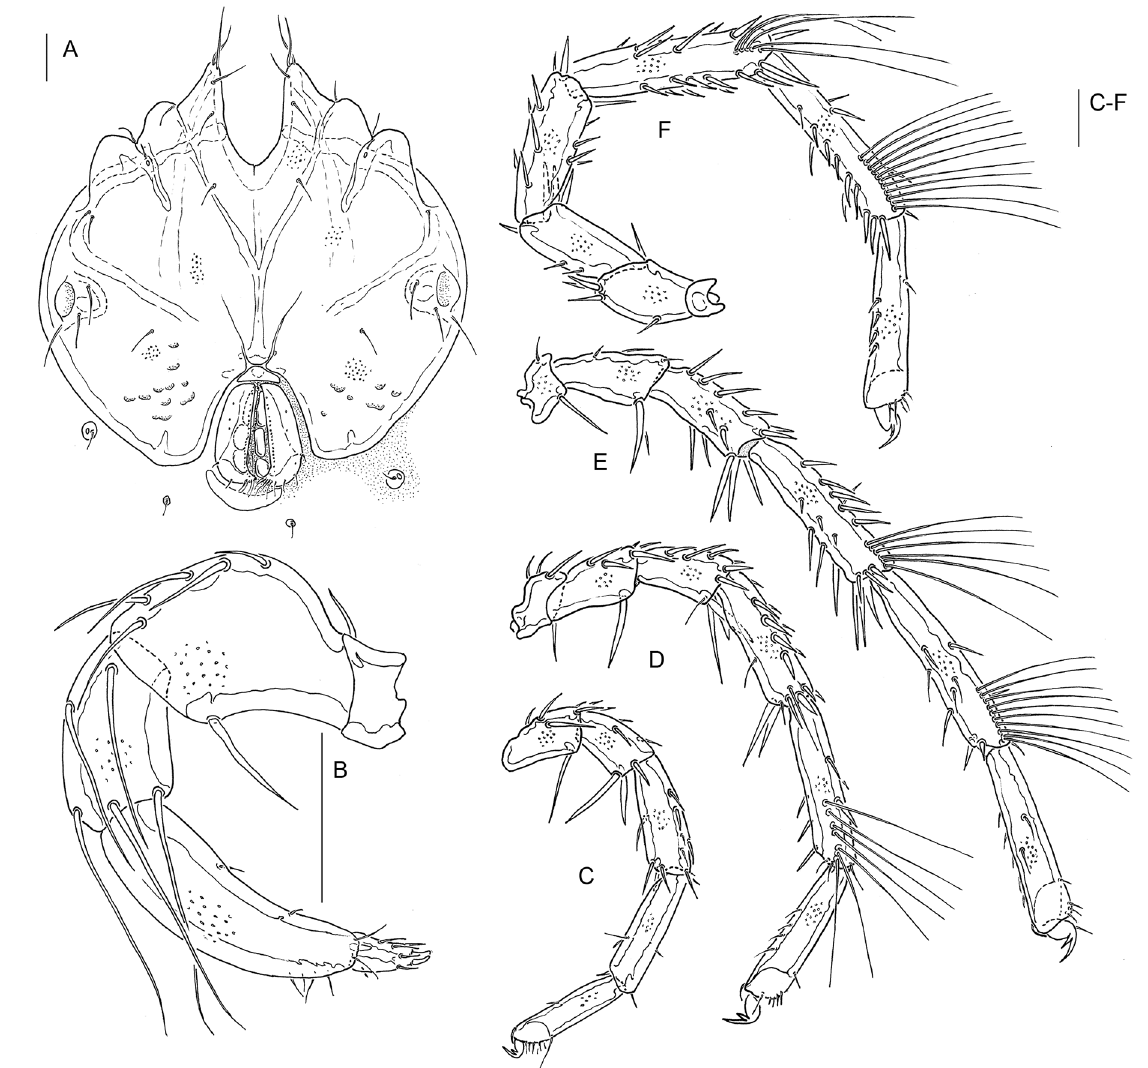
Fig. 8. Lebertia ( Pilolebertia ) obscura Thor, 1900, ♂ from the type locality. A . Coxal field. B . Palp. C . I-L. D . II-L. E . III-L. F . IV-L. Scale bars = 100